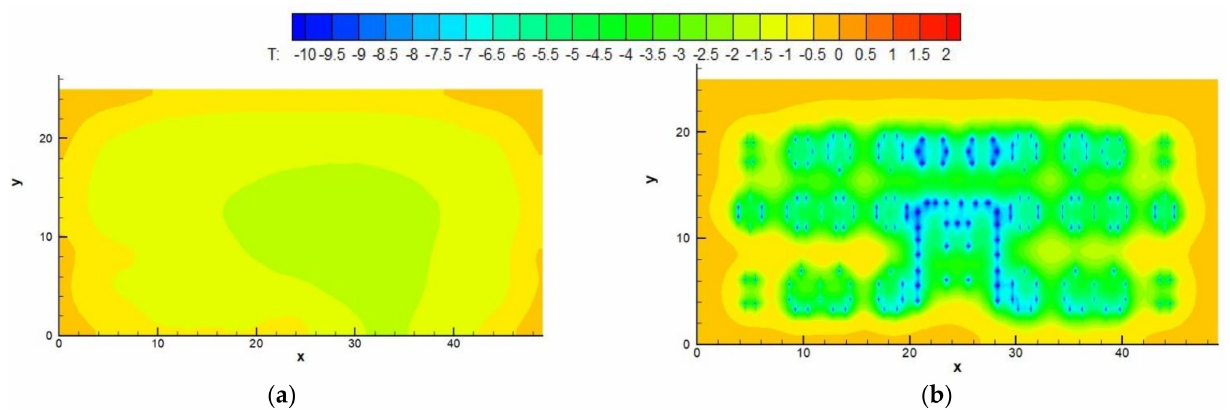
Figure 7. Temperature fields in the { x , z } plane under Building I in October 2021 ( a ) and November 2021 ( b ) in the vertical slices.